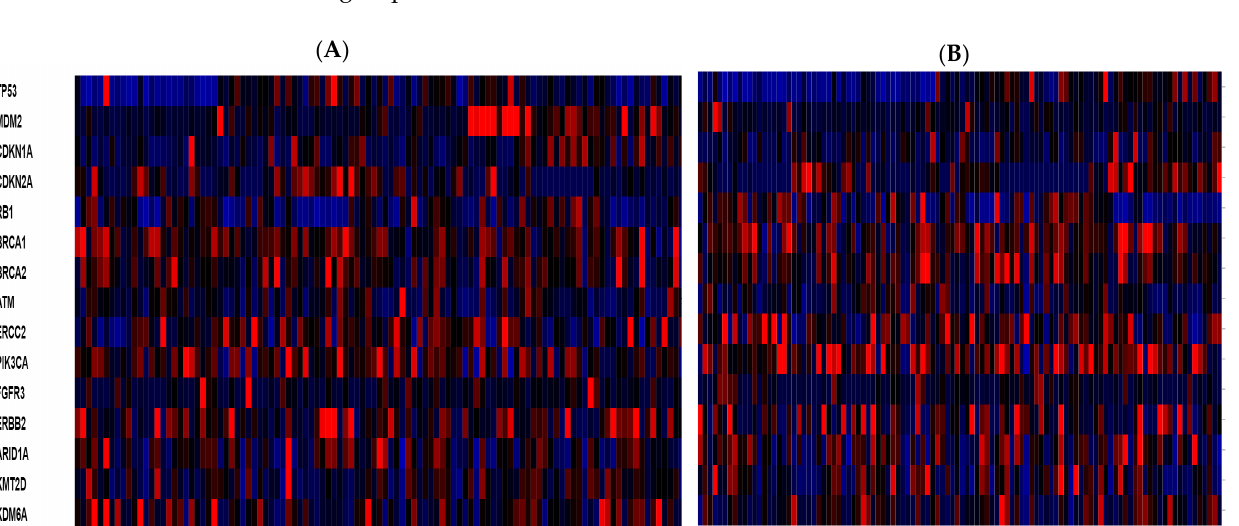
( B ) Figure 9. ( A ) Overall survival and ( B ) Disease Specific Survival of the high and low TMB groups.